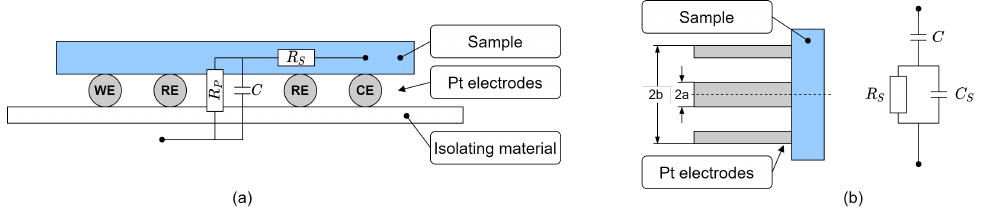
Figure 8. ( a ) Principle of the four-probe method and complex equivalent circuit. WE: Working electrode; CE: Counterelectrode; RE: Reference electrode. The electrodes are placed on a Teflon bed. For the two-probe method, two RE coincide with WE and RE (based on the work in [162]). ( b ) Open-ended coaxial probe with equivalent circuit (based on the work in [172]).